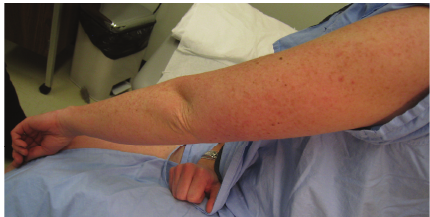
Figure 2: Left lateral upper limb demonstrating di ff use hyperkera- totic papules and plaques.